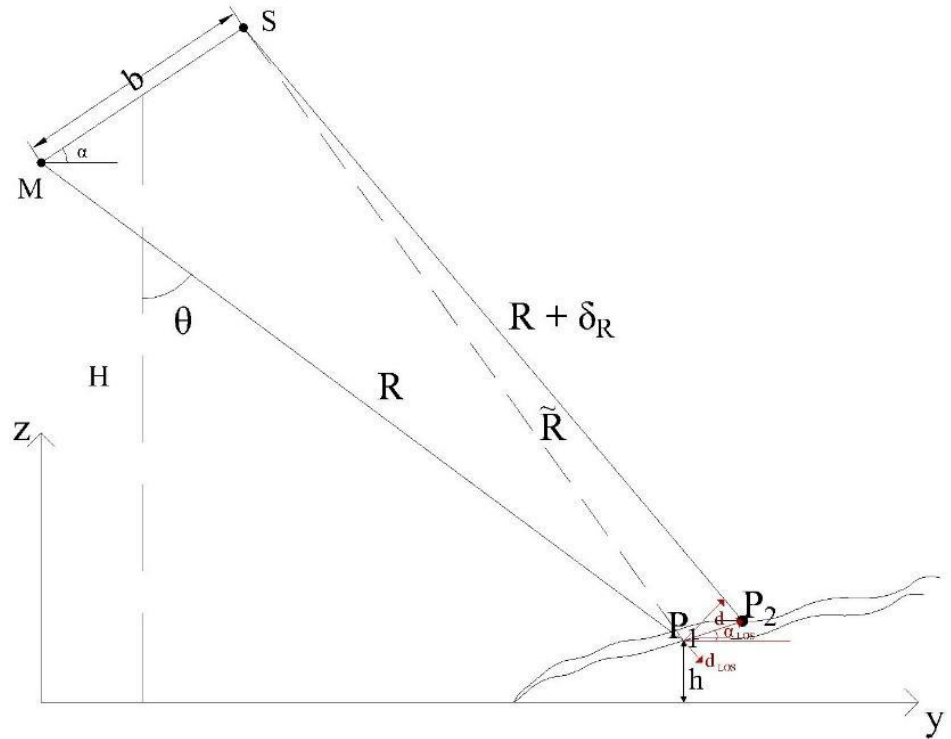
Figure 3. DInSAR geometry acquisition. Same as Figure 2 but considering the displacement d of the imaged point P on the ground. Note that P 1 and P 2 represent the point target positions of the master and slave acquisitions, respectively.